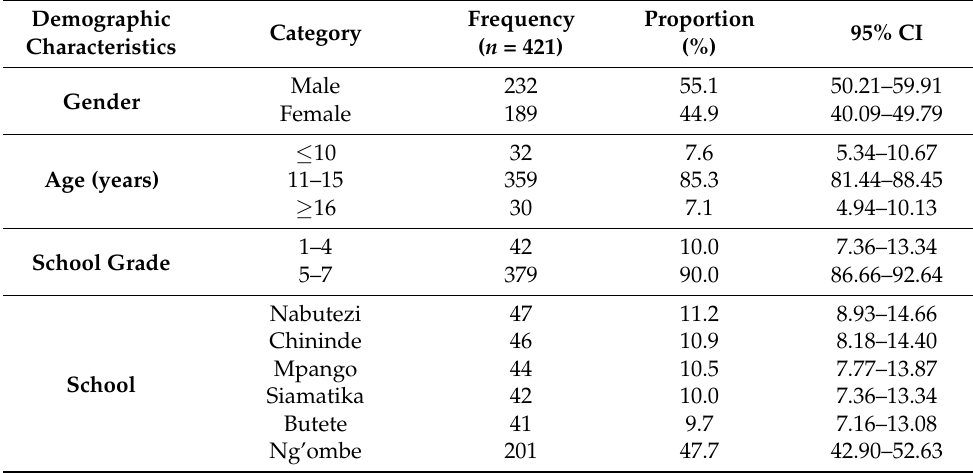
Table 1. Socio-demographic characteristics of study